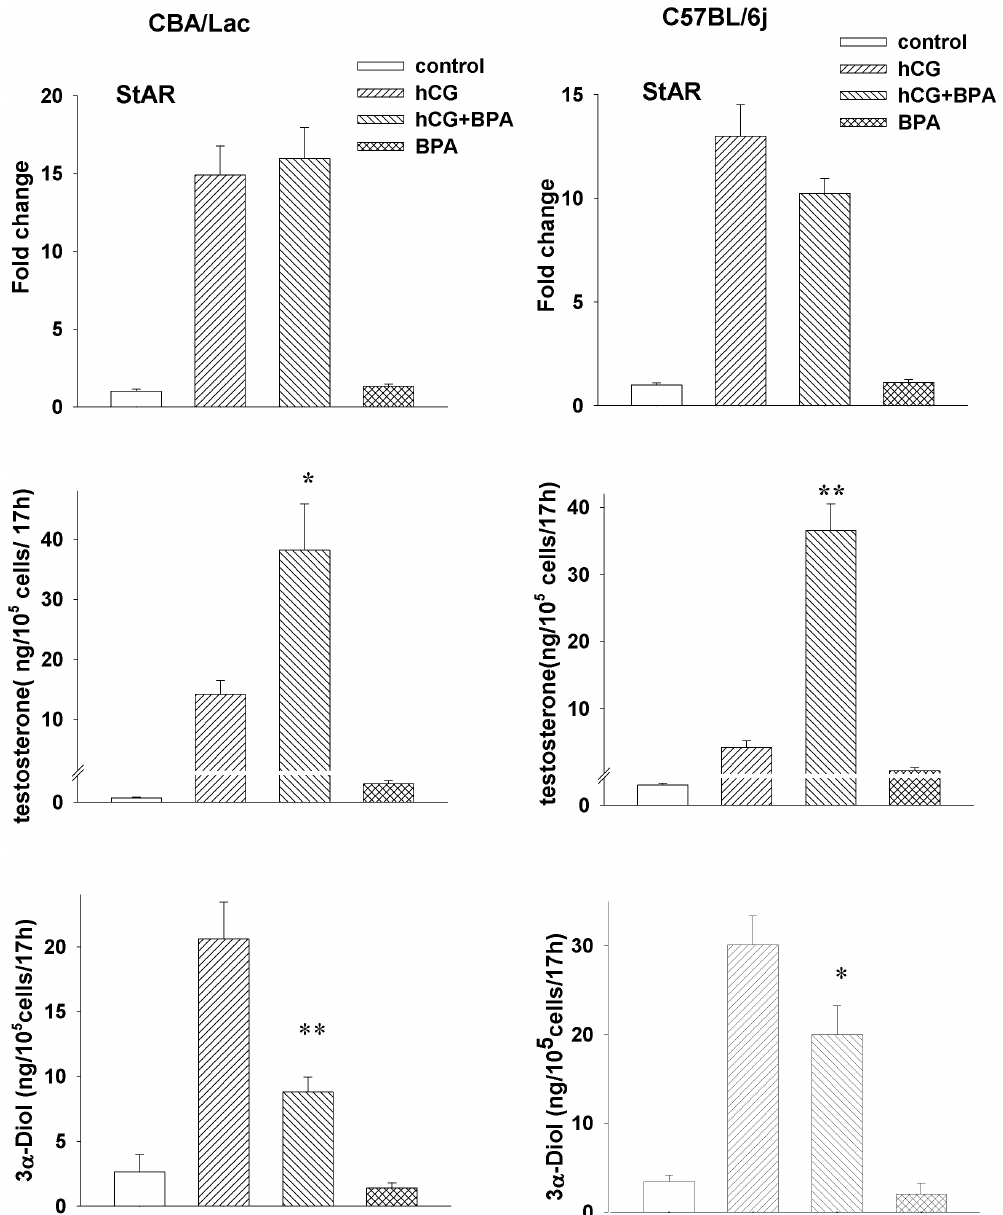
Figure 6. BPA suppresses testosterone metabolism and promotes hCG-stimulated androgen production by mouse Leydig cells. Each experiment was performed independently five times with similar results. Expression of StAR is expressed as fold change 6 S.E.M for four independent RNA preparations. *P , 0.05, **P , 0.01 compared to hCG treatment.